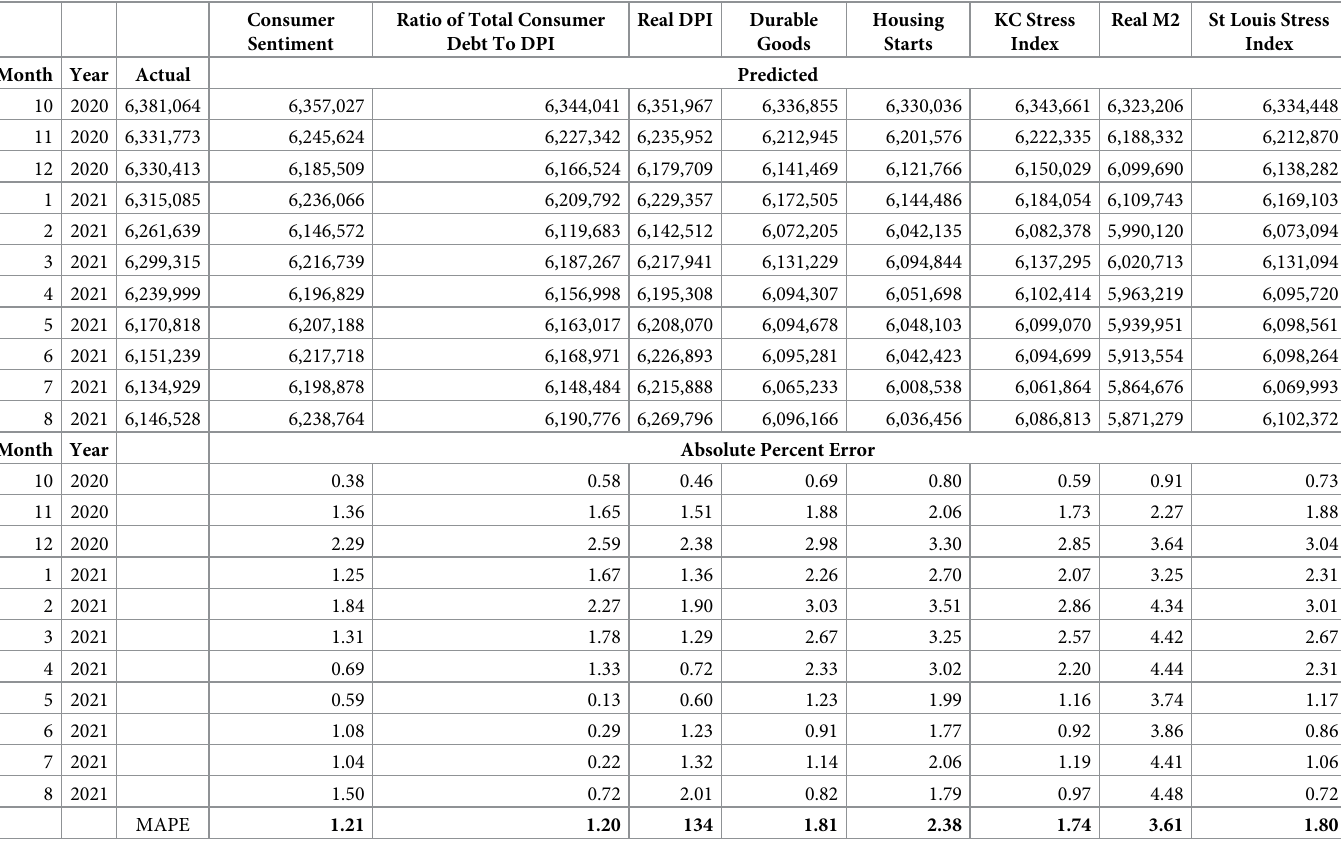
Table 6. Out-of-Sample predictive ability of WIC participation distributed lag models by macroeconomic